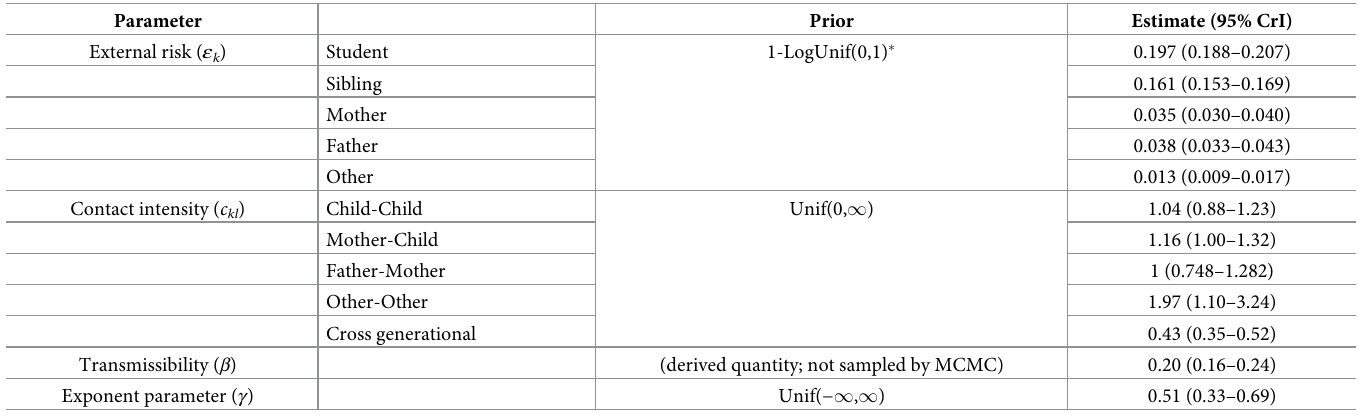
Table 3. Parameter estimates by the best